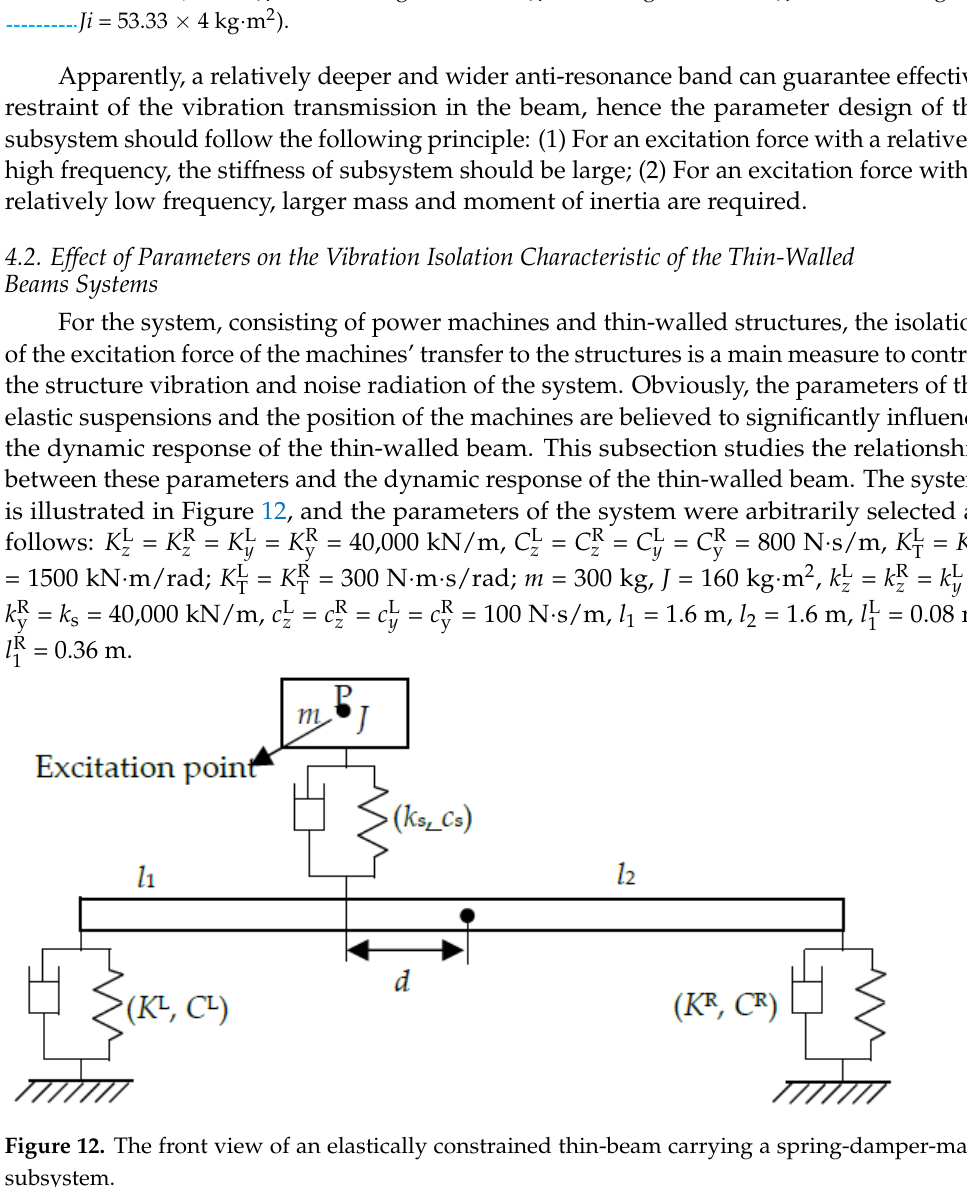
Figure 10. Effect of the mass of the subsystem on the frequency response at the right end of the beam ( m i = 266.67/2 kg, m i = 266.67 kg, m i = 266.67 × 2 kg, m i = 266.67 × 4 kg). Figure 12. The front view of an elastically constrained thin-beam carrying a spring-damper-mass subsystem.